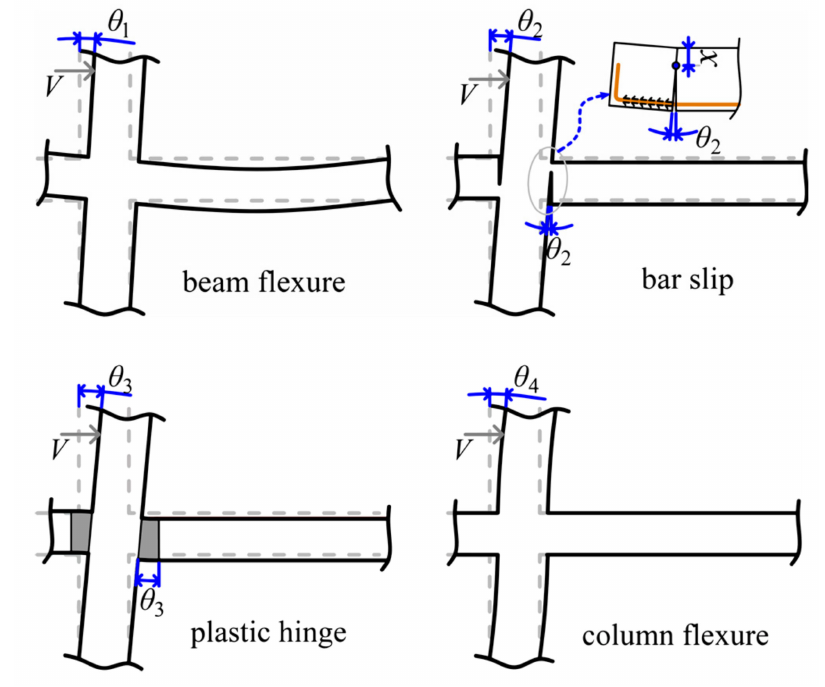
Figure 5. Four mechanisms contributing to column